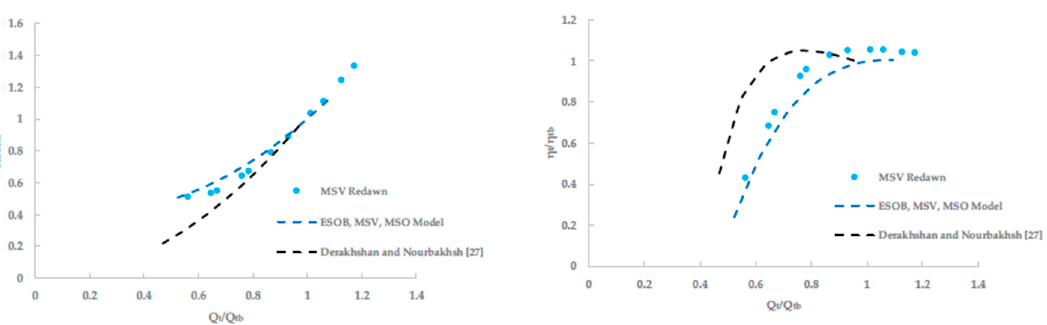
Figure 10. Experimental and theoretical performance curves for MSV pumps used in inverse mode.